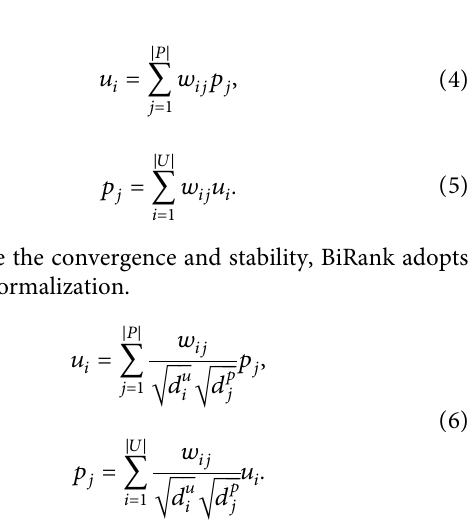
Figure 2: Burstiness-weighted developer-project bipartite network. The edge weight is function of burstiness which can be calculated using interaction